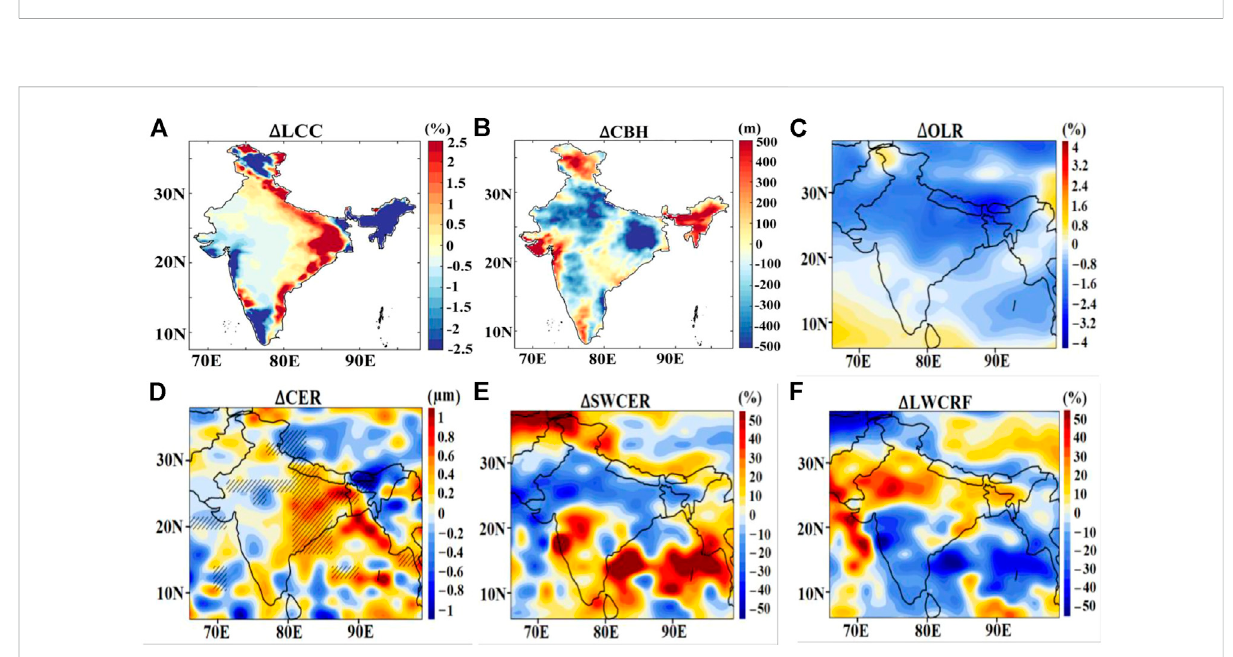
FIGURE 2 Spatial distributionof anomalies(2020 — mean of 2016 – 2019) averaged for the lockdown period for (A) Low Cloud Cover ( Δ LCC) and (B) Cloud Base Height from ERA5 ( Δ CBH). The rest of the fi gures are for simulated anomalies (C19 — CTRL) averaged over 10 members and for the lockdown period, (C) outgoing longwave radiation ( Δ OLR, %), (D) Cloud Effective Radius ( Δ CER, µm), (E) Short Wave Cloud Radiative Forcing ( Δ SWCRF, %), (F) Longwave Cloud Radiative Forcing ( Δ LWCRF, %). Hatching shows the area where mean differences between C19 and CTRL are statistically signi fi cant at a 90% con fi dence